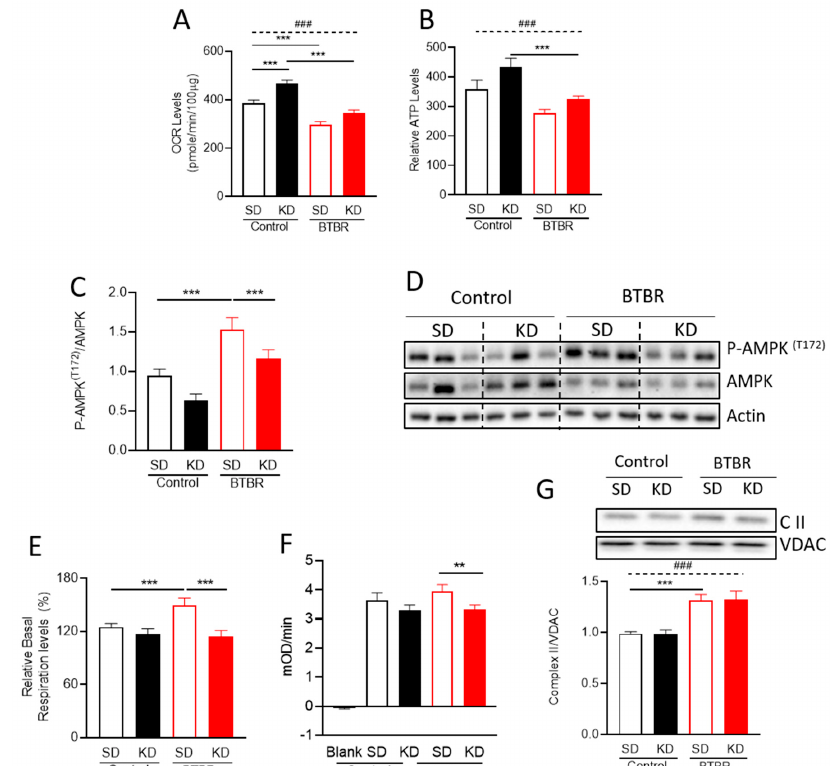
Figure 2. The ketogenic diet (KD) reverses alterations in mitochondrial bioenergetics in BTBR mice. Isolated mitochondria were used for mitochondrial bioenergetics assays with a Seahorse XF24 analyzer. ( A ) The bar graphs depict the oxygen consumption rates (OCR) under basal conditions and ( B ) relative ATP production using pyruvate and malate as substrates. ( C ) Densitometry analysis of P-AMPK T172 . ( D ) Representative blots for the densitometry analysis in Figure 2C. ( E ) Relative basal respiration levels via Complex II, after the addition of ADP (after subtraction of antimycin A-insensitive OCR (non-mitochondrial respiration)). The enzyme activity ( F ) and protein expression levels ( G ) of electron transport chain Complex II. Data are shown as mean±SEM, n = 6 per group. Data were analyzed by two-way ANOVA. The significant effects (main effects from two-way ANOVA) are presented as: ### p <0.001. Further, the significant differences between groups revealed by the post-hoc analysis, are presented as: *** p <0.001; ** p <0.01.